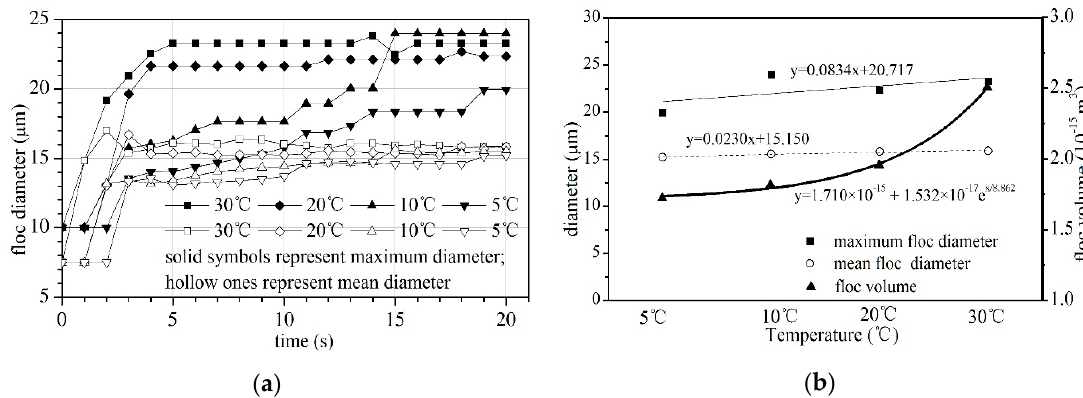
Figure 4. Floc properties of each case. ( a ) Time histories of maximum floc size (solid symbols) and mean floc size (hollow symbols) for the 5 °C, 10 °C, 20 °C, and 30 °C cases; ( b ) The maximum floc diameter, mean floc diameter (the left axis, with unit of µ m) and floc volume (the right axis, with unit of 10 − 15 m 3 ) at the end of the simulation. In ( b ), the thin solid line and dashed line represent the line fit of maximum and mean floc diameters, respectively, and the thick solid line is the exponential fit of floc volume.